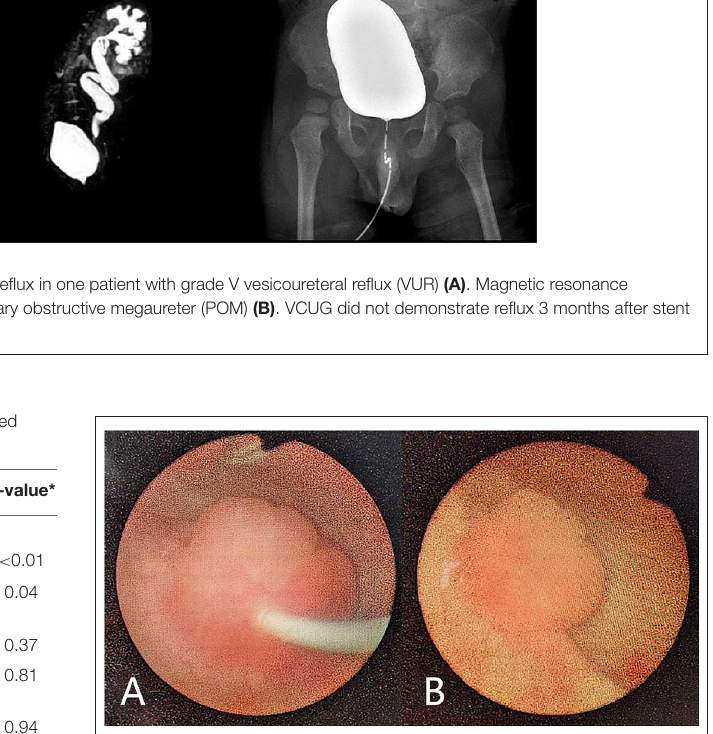
FIGURE 3 | Cystoscopy performed while removing the ureteral stent. The protruding portion of the ureter in the bladder appeared nipple shaped with a ureteral stent in the ureter (A) . The protruding portion of the ureter in the bladder appeared nipple shaped (B)